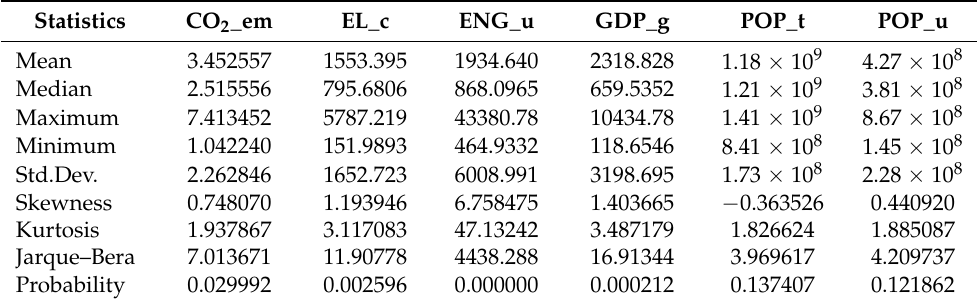
Table 2. The Summary Statistics of